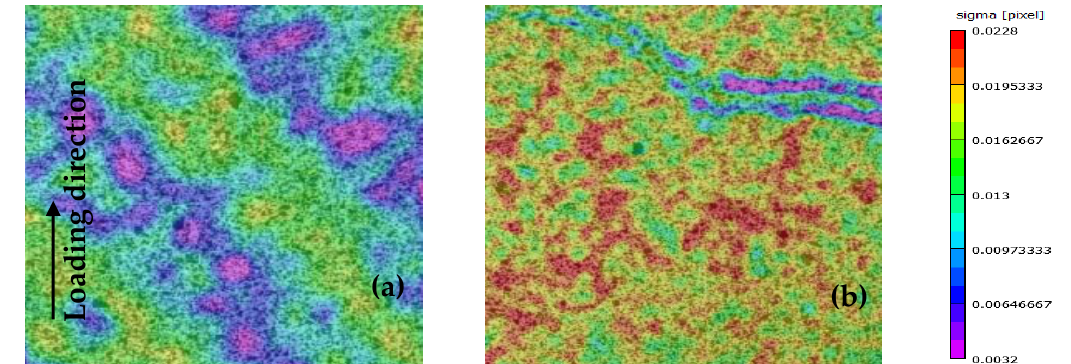
Figure 13. DIC σ pattern for a [0°/30°] 2s laminate ( a ) before and ( b ) after delamination.